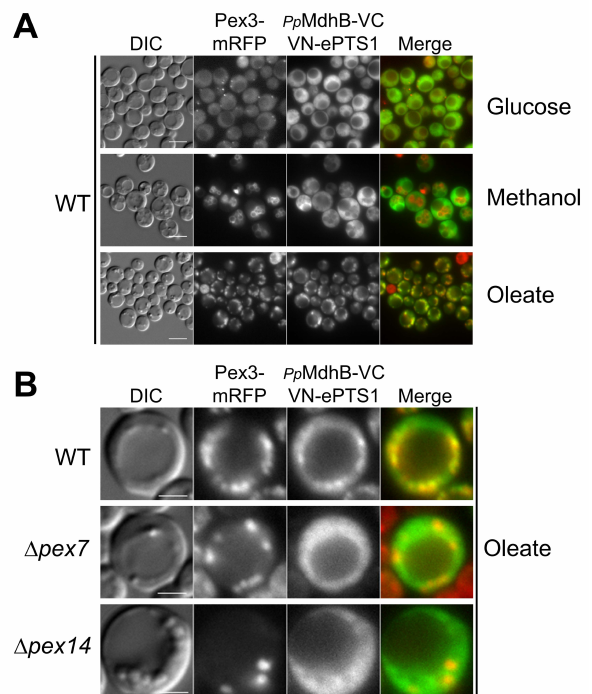
Figure 5. Localization of Pp MdhB using the divergent BiFC assay. ( A ) Wild-type cells were grown overnight in glucose, methanol, and oleate. Bars: 5 µ m. ( B ) Wild-type, ∆ pex7, and ∆ pex14 cells grown overnight in oleate. Bars: 2 µ m. Peroxisomes were visualized using